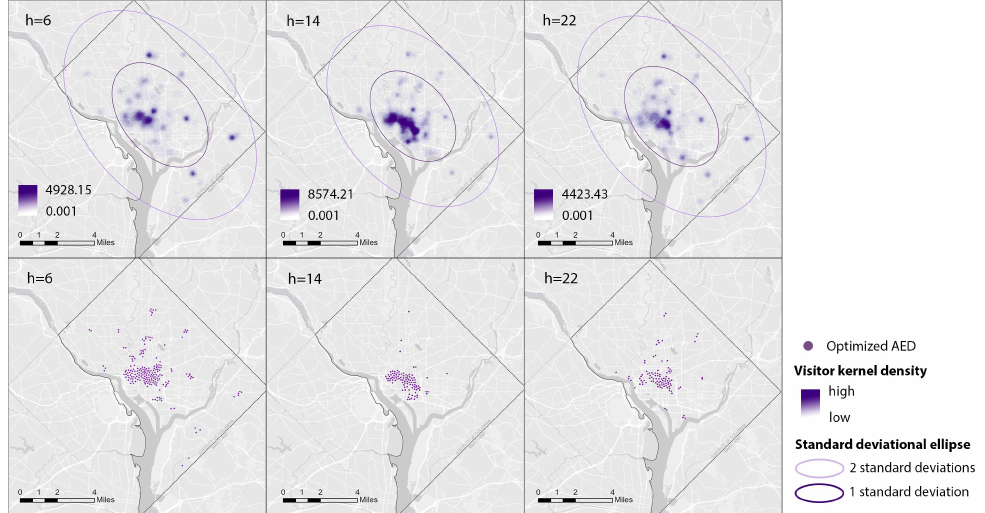
Figure 5. Kernel Density Maps of Visitors and Corresponding Optimized AED Locations at Three Particular Hours (k = 100).